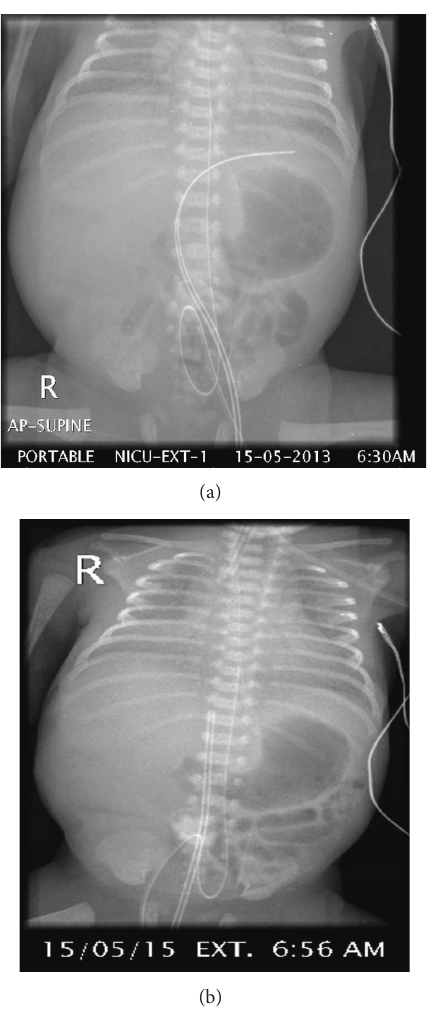
Figure 1: Plain X-ray of the abdomen demonstrating the UVC directed to the left within the splenic vein (a) which is corrected after 26 min (b).